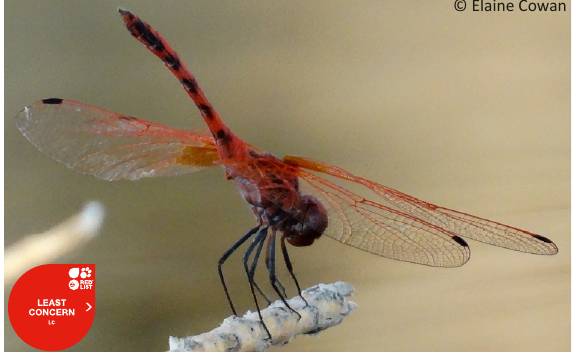
Image 26. Male Trithemis arteriosa , 28 May 2014. Red wing-veins and black legs. Slender red abdomen with lateral black markings. Large amber patch at hindwing base.